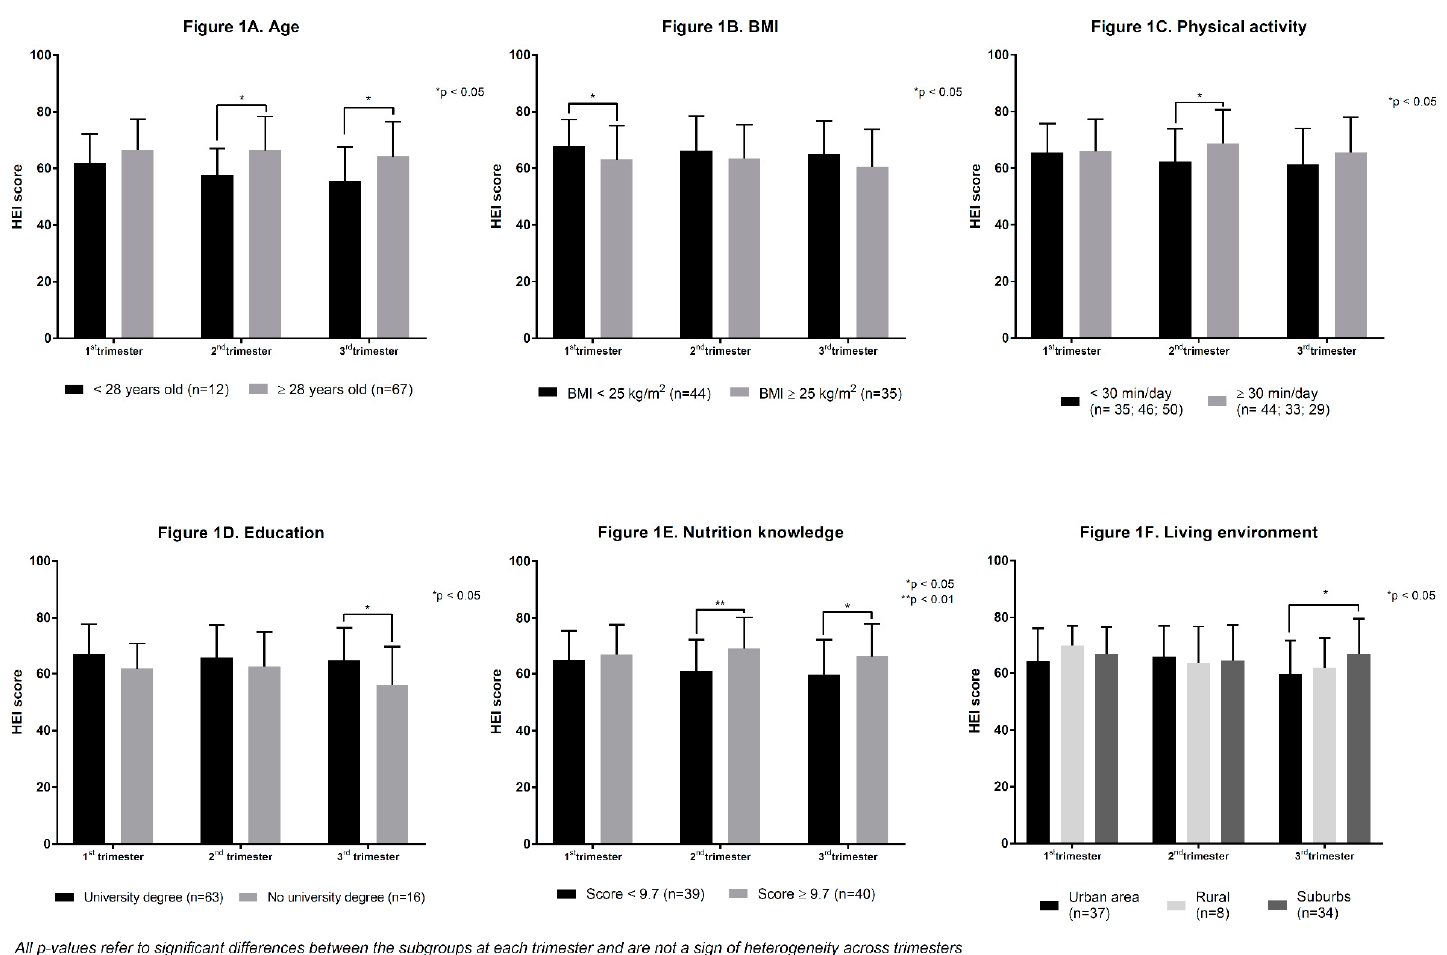
Figure 1. Trimester-specific diet quality according to maternal characteristics: (A) Age; (B) BMI; (C)Physical activity; (D) Education; (E) Nutrition knowledge; (F) Living environment.